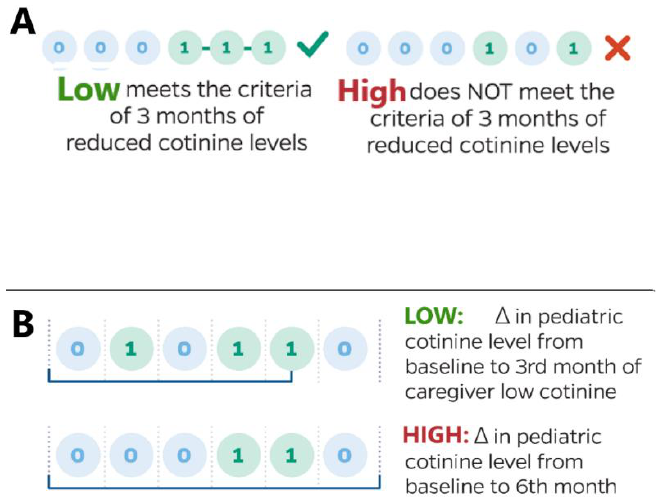
Figure 1. Post hoc analyses overview. Subset ( A ): Schema used to divide caregivers into 2 classifications: “low” versus “high”. Caregivers within the “low” classification had at least three low monthly cotinine levels, compared to baseline (represented by the number “1”). The three low levels do not have to be consecutively observed for classification as “low”; solely 3 low time points need to be noted over the 6 month trial. Achieving ≤ 2 months of low cotinine levels default to the “high” classification status; Subset ( B ): Measurement schema used to measure the reduction in child cotinine levels. For those caregivers achieving a “low” status, we measured the di ff erence in child cotinine levels at the 3rd time point, compared to baseline values. For those caregivers not designated under a “low” status, we measured the change in cotinine level at 6 months, compared to baseline.